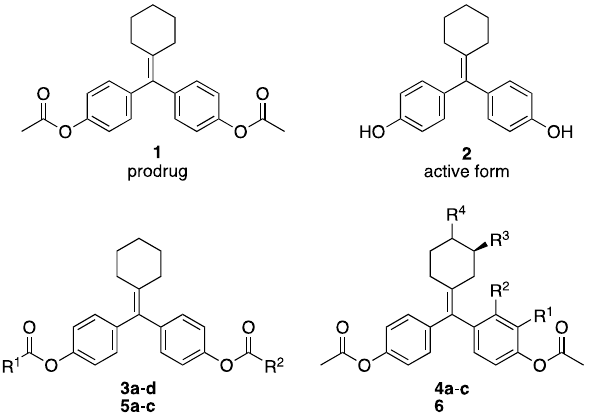
Figure 1. Chemical structures of cyclofenil ( 1 ), its active form 2 , asymmetric analogs 3a – d and 4a – c , and symmetric analogs 5a – c and 6 .